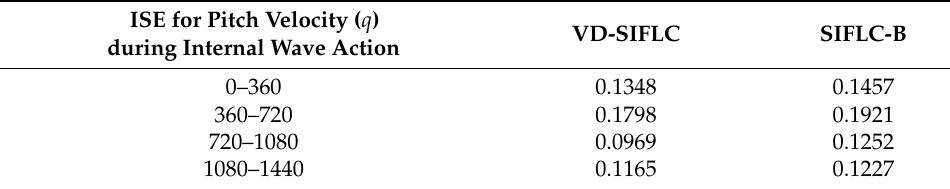
Table 7. Robustness comparison of VD-SIFLC and